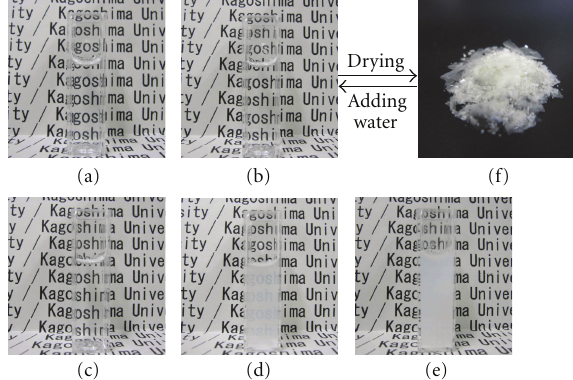
Figure 2: Photographs of aqueous dispersions (1.0w/v%) of SQ/ZrO 2 -NPs obtained with various feed molar ratios for APT- MOS/ZTB: (a) 1.0, (b) 0.3, (c) 0.2, (d), 0.1, and (e) 0 and (f) solid state of SQ/ZrO 2 -NP (feed molar ratio of APTMOS/ZTB = 0.3).